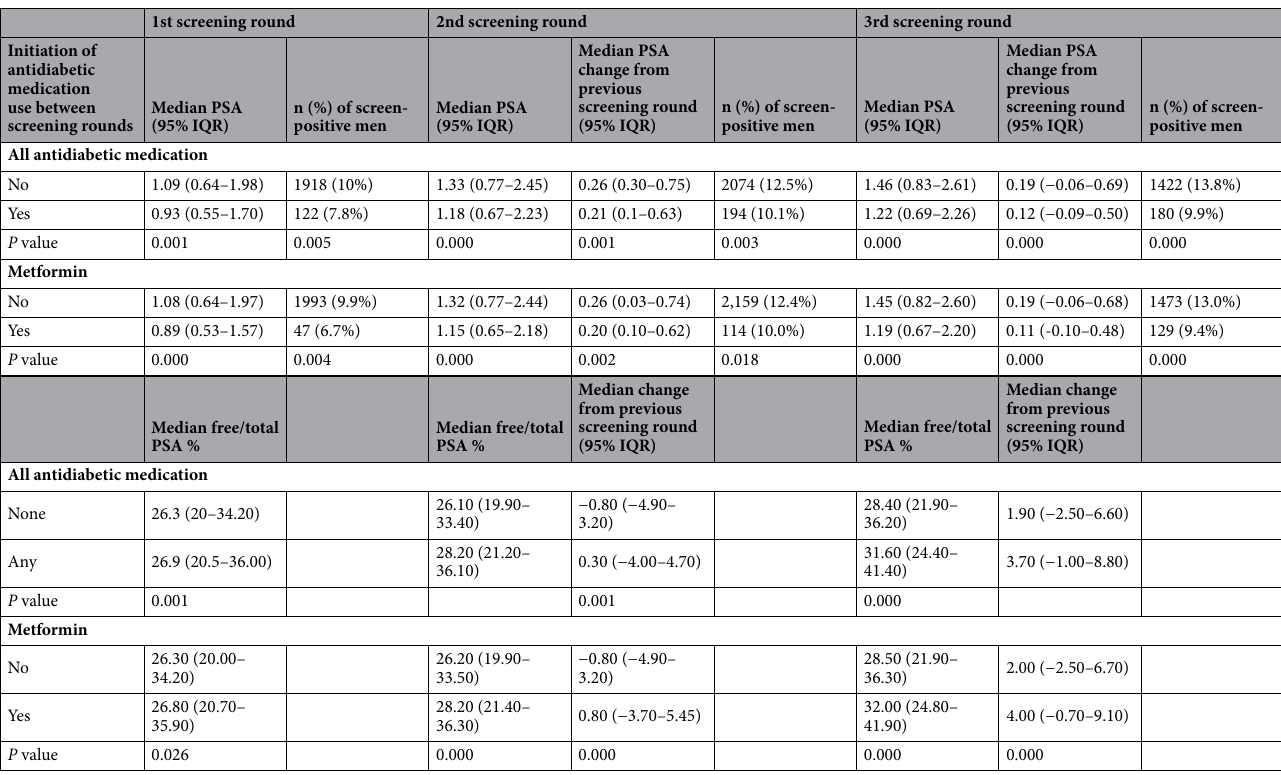
Table 2. Median PSA and change in PSA value between screening round among antidiabetic medication users and non-users. Study population of 78,615 men from the Finnish Randomized Study of Prostate Cancer Screening.